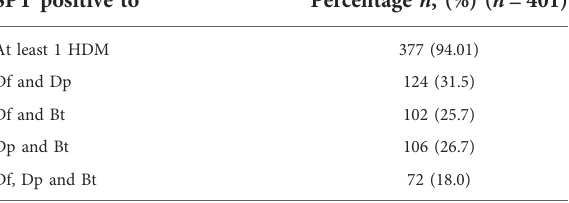
TABLE 4 Polysensitization to